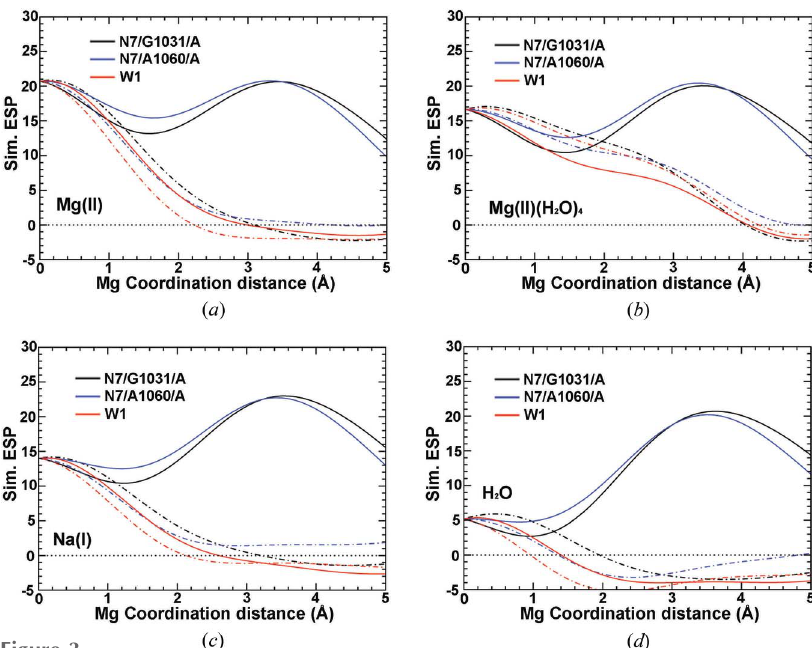
Figure 3 One-dimensional plots of simulated ESP maps centered at the Mg-J1 site. ( a )–( d ) The map contains either Mg(II) or Mg(II)(H 2 O) 4 , Na(I) or H 2 O. The Fourier terms were limited to 2.5 A˚ and the mean atomic B factor of 41.25 A˚ 2 was used.